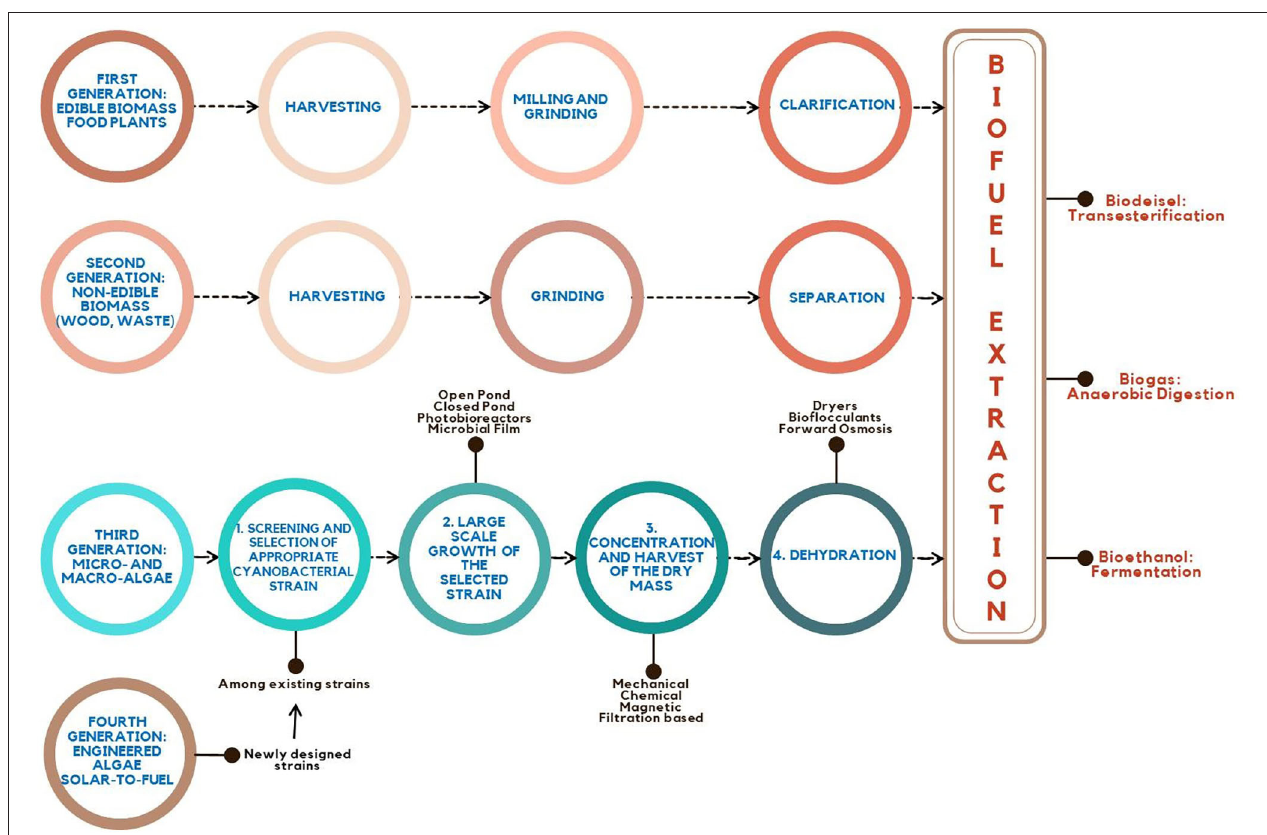
FIGURE 3 | From the first generation to the fourth generation: overview of steps involved in biofuel production technology.